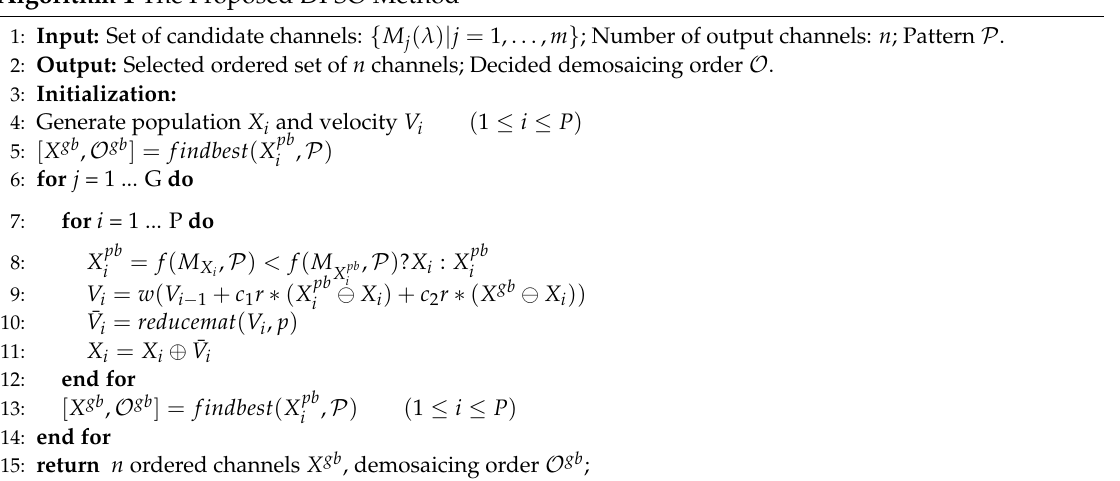
Algorithm 1 The Proposed DPSO